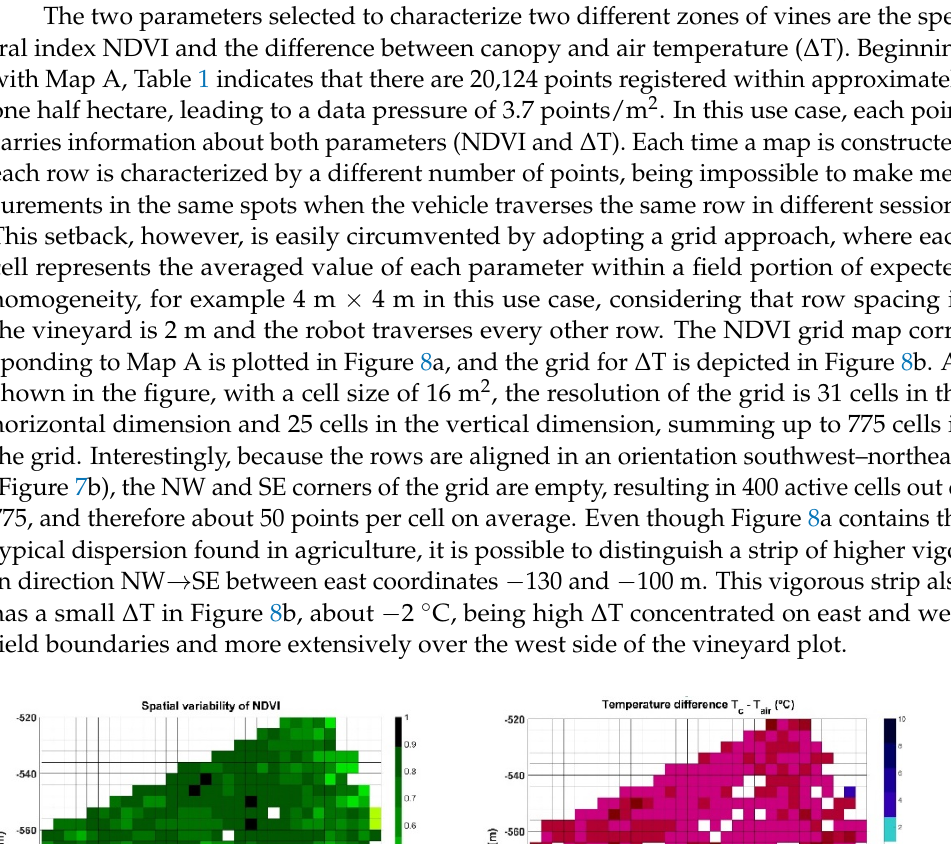
Table 1. Mapping sessions providing data for a use case on harvesting zoning in vineyards.